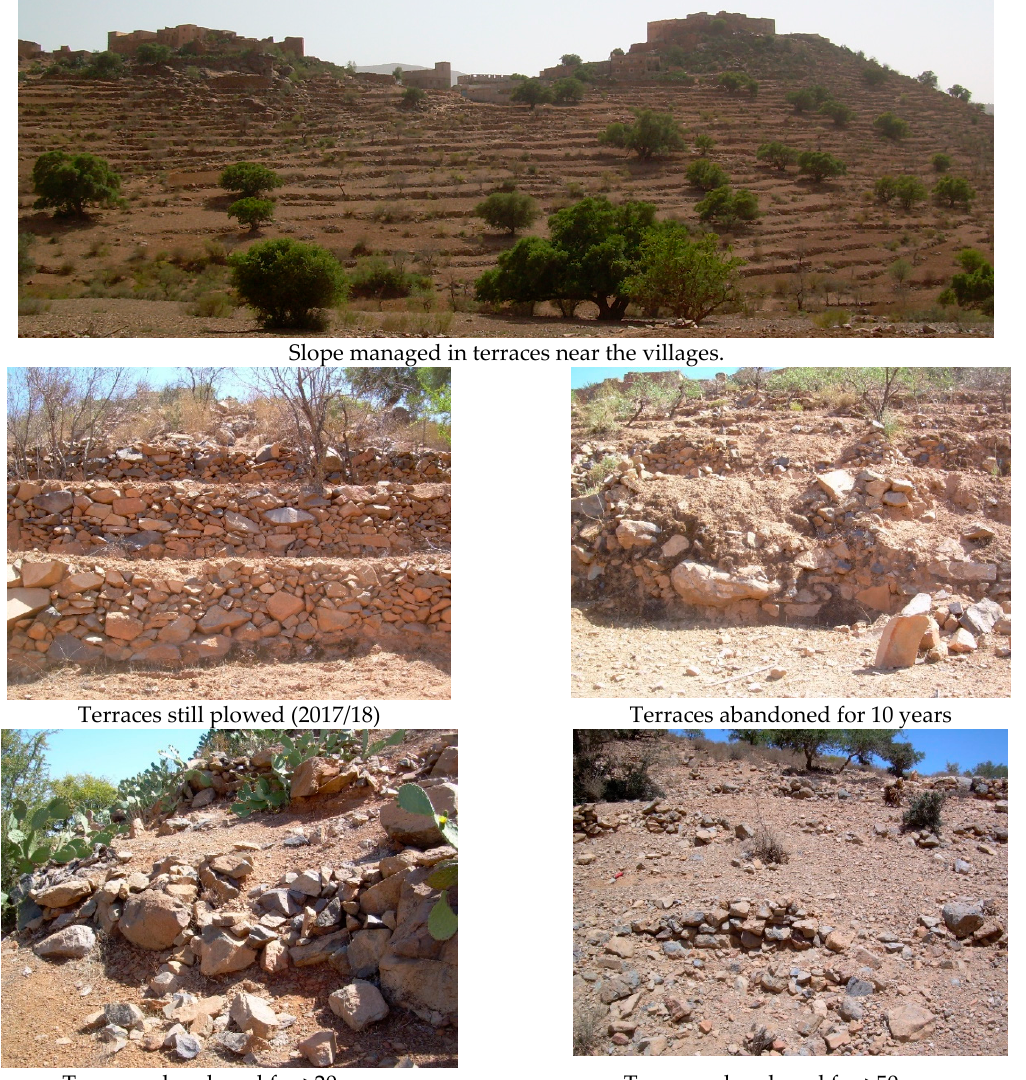
Figure 3. States of the terraces in the territory of Tizerkine–Timzemzit.